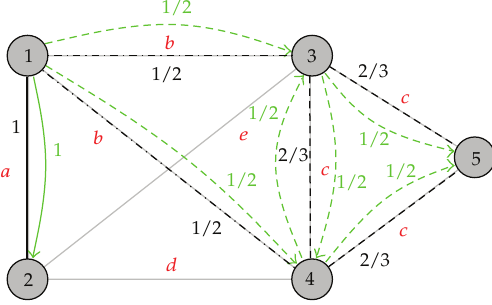
Figure 8: LP solution of DCut t with objective value f lp (cid:6) (cid:2) 2 (cid:9) 1 (cid:3) / 6 (cid:2) l b (cid:6) 1 / 2 , l c (cid:6) 2 / 3 , l a (cid:9) l d (cid:9) l e ≥ 1 , w . l . o . g . l a (cid:6) 1 (cid:3) . The green arcs depict the arc variables with their according LP values. The solution